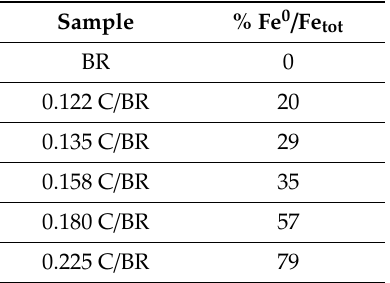
Table 3. Percentage of metallic iron / total iron content of BR and 4 di ff erent C / BR ratio sinters determined with the Zhiyong Xu method